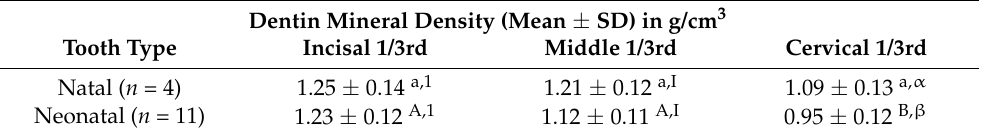
Table 3. Dentin mineral density (in g/cm 3 ) at incisal, middle, and cervical thirds of natal/neonatal teeth.